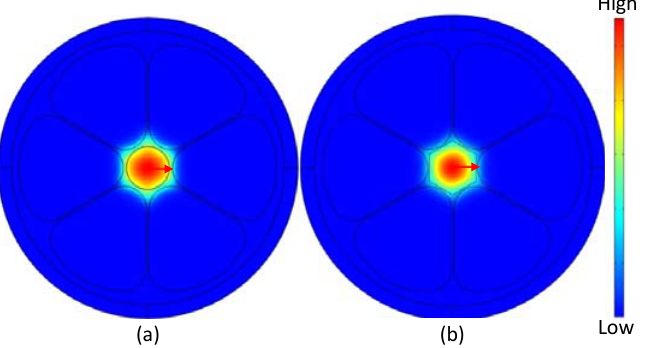
Figure 8. Field pattern of the x-polarization core mode for ( a ) circular, and ( b ) hexagonal core at optimum design conditions.